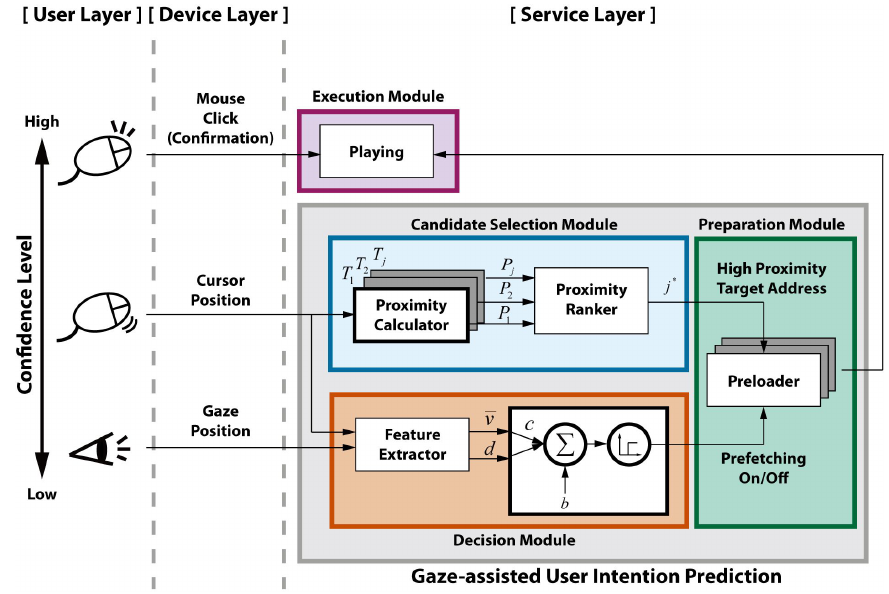
Figure 5. The proposed gaze-assisted user intention prediction based on TIM.